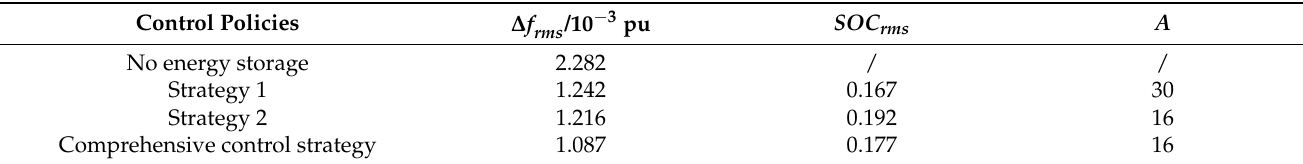
Table 5. Evaluation index of FM under 60 min continuous load